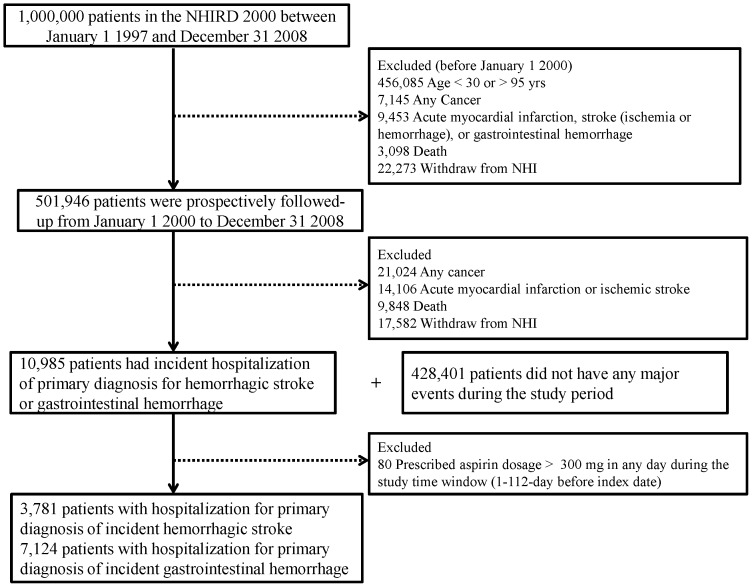
Study flowchart.